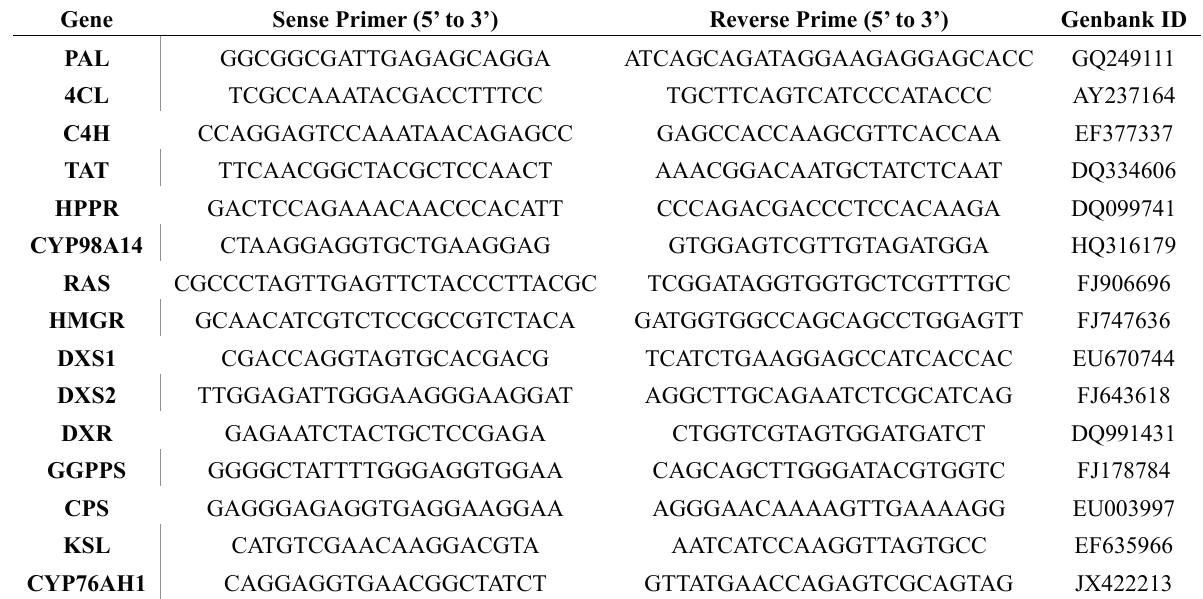
Table 1. List of RT-qPCR